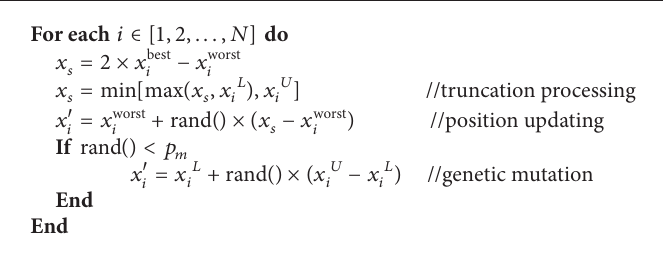
Algorithm 2: Generating a new harmony by NGHS